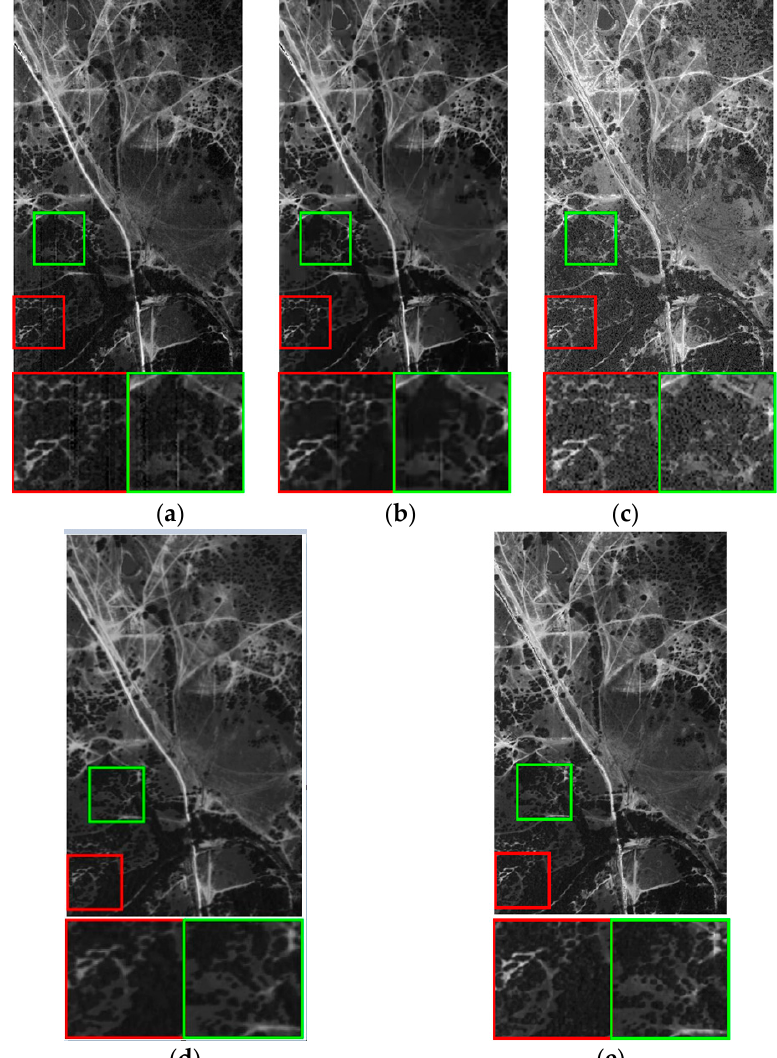
Figure 9. Visual results on band 4 of terrain dataset: ( a ) Captured actual band, ( b ) Restoration results of VBM3D based method, ( c ) Restoration results of Godec based method, ( d ) Restoration results of SLrank based method, ( e ) Restoration results of the proposed method.